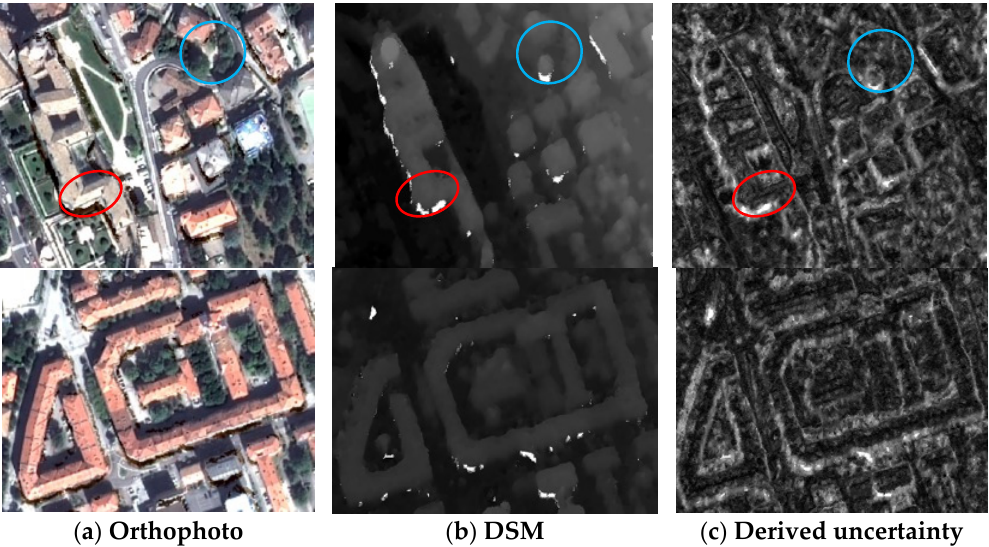
Figure 2. Two examples of the uncertainty map associated with dense image matching: ( a ) orthopho- tos; ( b ) DSMs grey-scaled by height; ( c ) uncertainty maps, black to white: low to high uncertainty (scaled from 0 to 10,000, unitless). Red and blue circled regions show examples of high